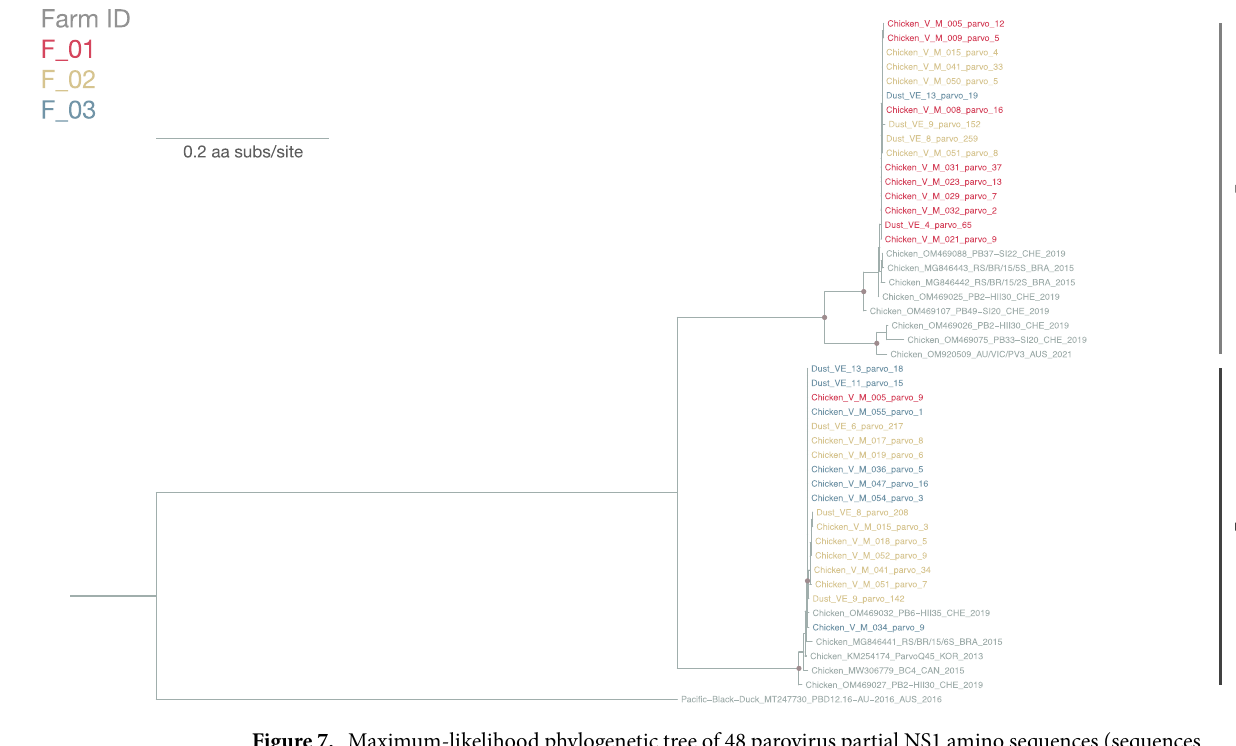
Figure 7. Maximum-likelihood phylogenetic tree of 48 parovirus partial NS1 amino sequences (sequences from this study: 34; reference sequences: 14; 700 sites) reconstructed using a best-fit evolutionary model JTT + FC + R2. For clarity, only bootstrap supports > = 70 are shown as a light brown node point. Tip labels of our samples are color-coded by corresponding farm ID. Reference sequences are in grey. The tree is rooted to a chaphamaparvovirus 1 strain, named PBD12.16-AU-2016, identified from Pacific black duck (GenBank accession number: MT247730).